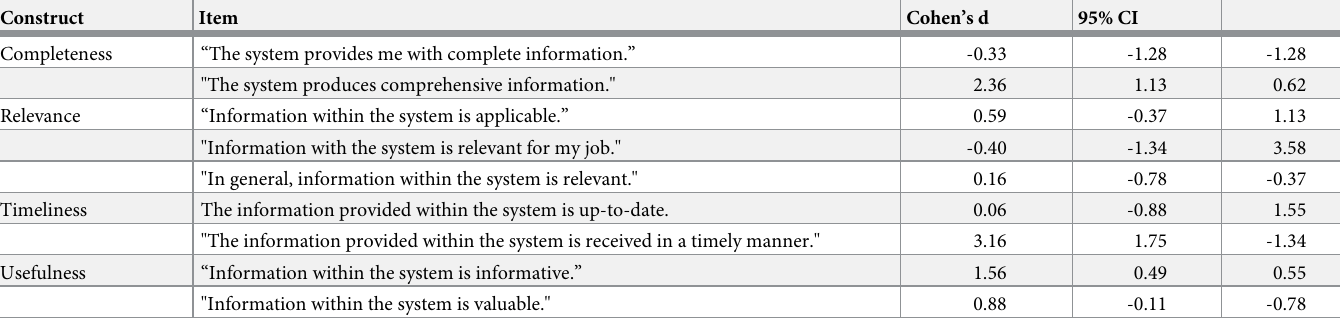
Table 3. Survey results of the effect size for comparison of contextual information quality with current method and the software.